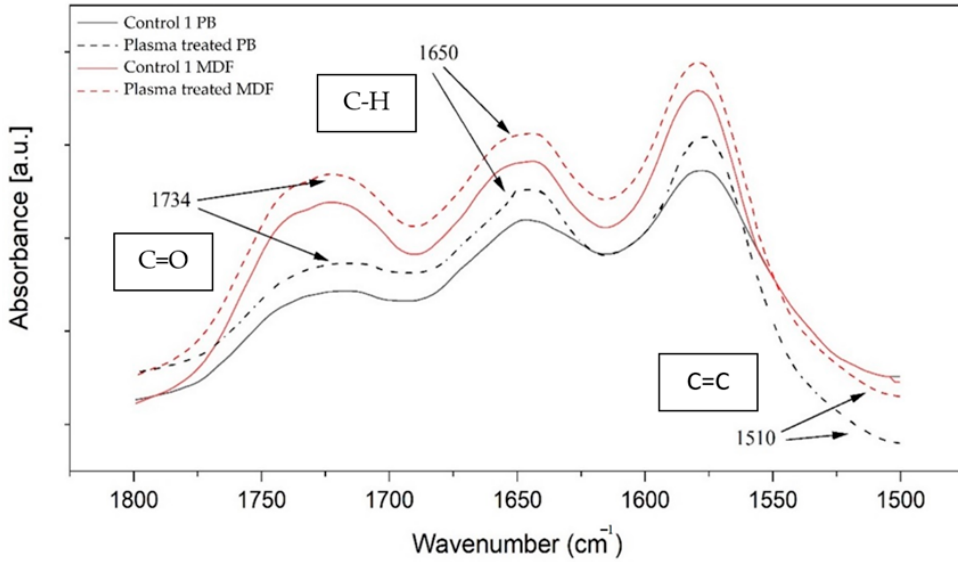
Figure 2. FTIR spectroscopy of untreated and plasma-treated PB and MDF composite panels.